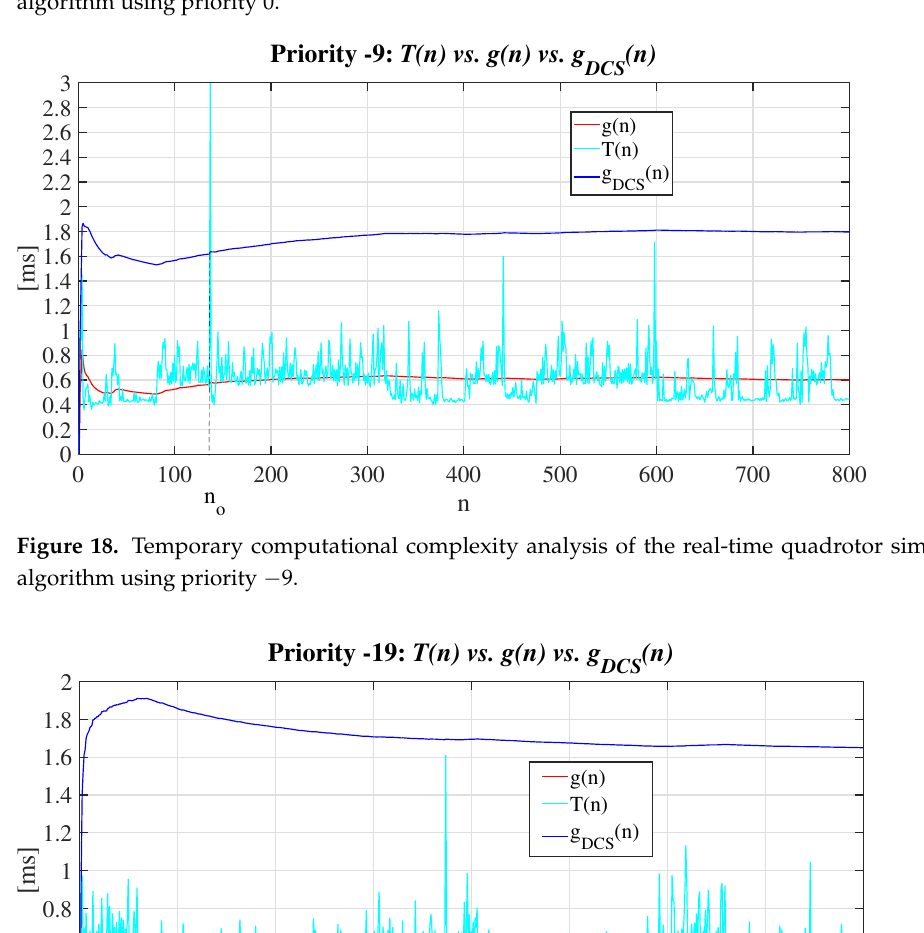
Figure 17. Temporary computational complexity analysis of the real-time quadrotor simulation algorithm using priority 0.